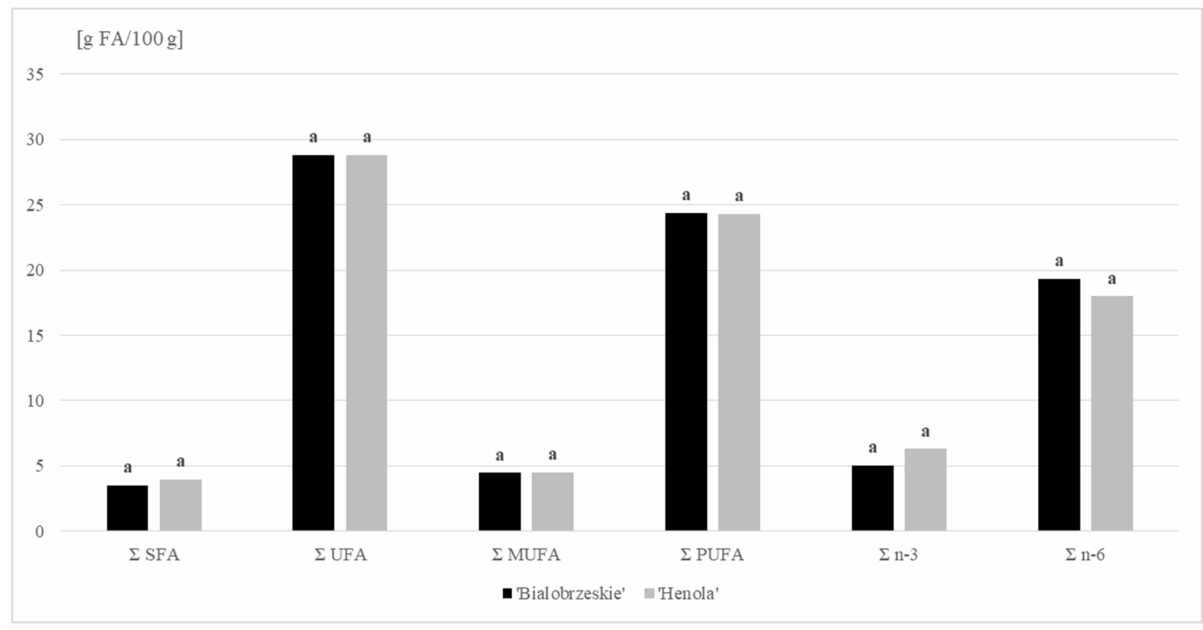
Figure 1. Fatty acids (FA) content (g/100 g DM) in ‘Bialobrzeskie’ and ‘Henola’ seeds. Table 3. Lipid health indicators of hemp seeds. Quality